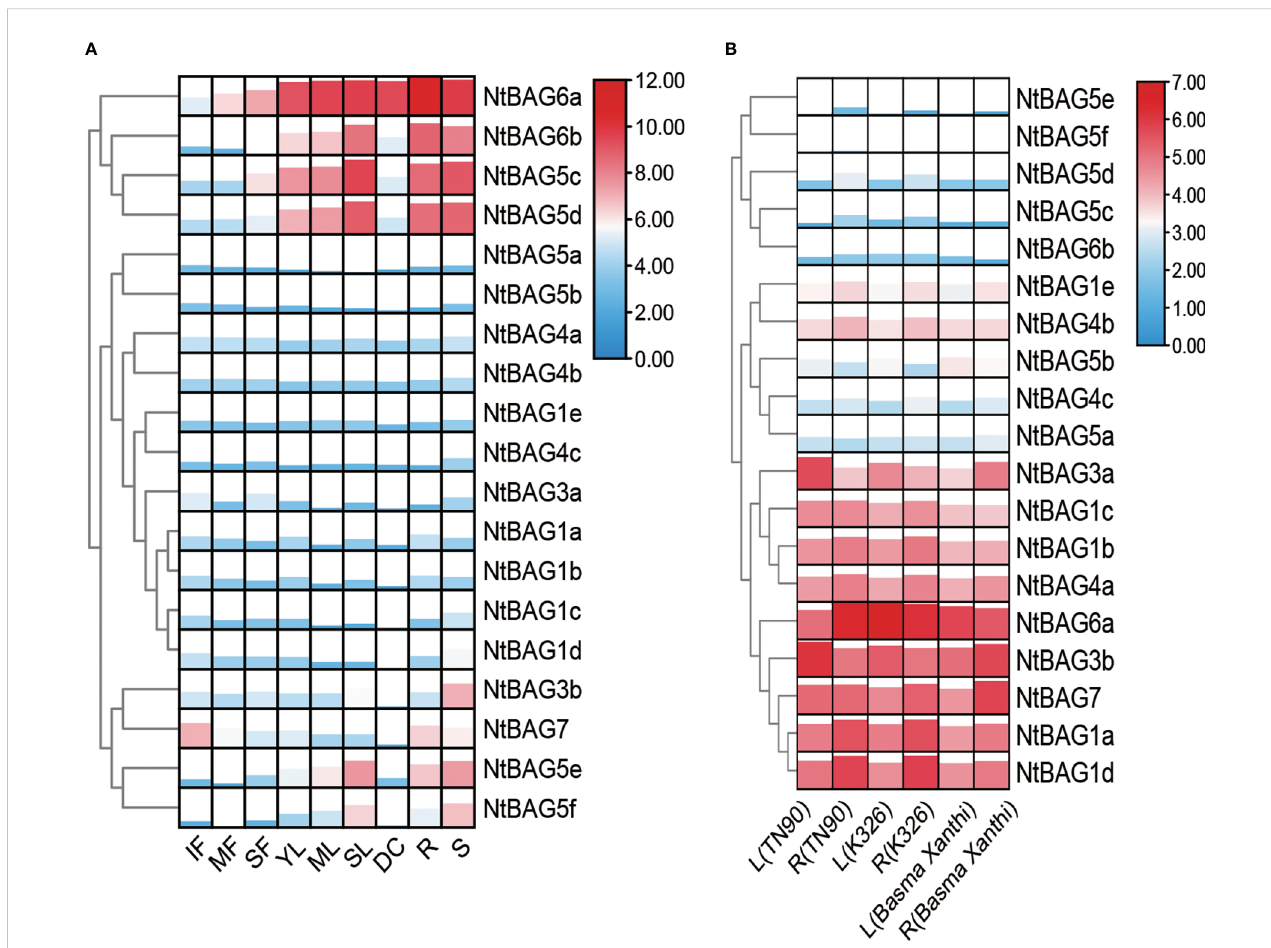
FIGURE 3 Expression patterns of BAG genes. (A) Expression patterns in different tissues and developmental stages of tobacco. (B) BAG gene expression patterns of leaf and root in different varieties. MF, mature fl ower; R, root; DC, dry capsule; ML, mature leaf; SF, senescent fl ower; SL, senescent leaf; S, stem; IF, immature fl ower; YL, young leaf. The expression levels are represented by the color bar